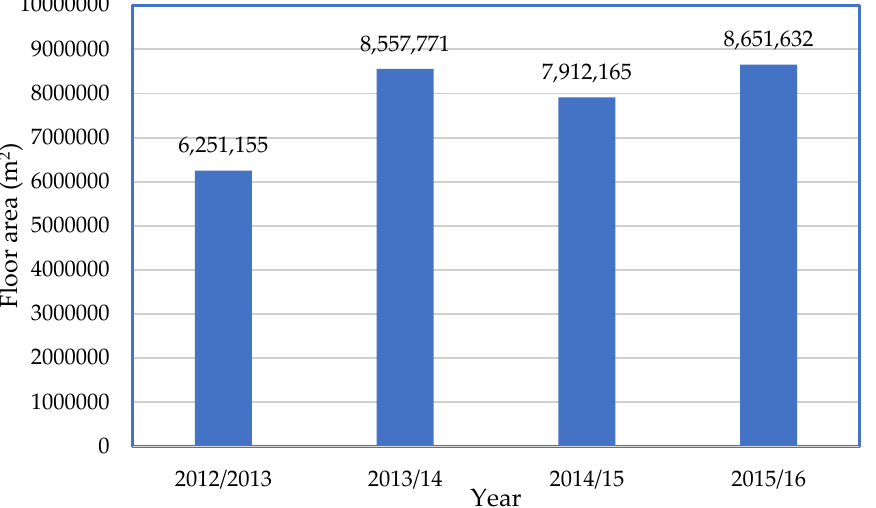
Figure 5. The constructed floor area in Kuwait during the period 2012 – 2016.